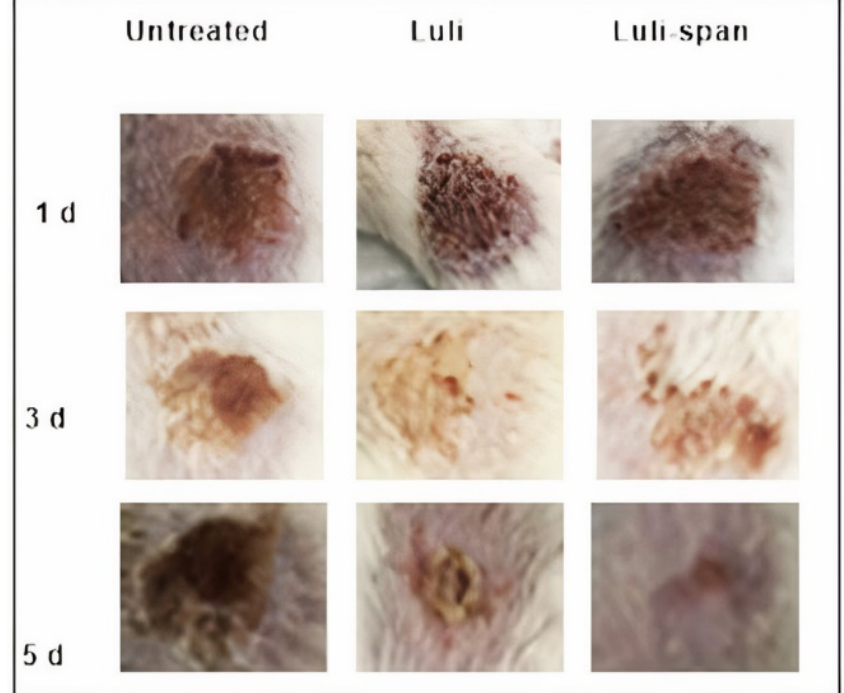
Figure 5. Macroscopic evaluation of infection was measured by a score of erythema in mice of all three groups at 1, 3 and 5 days. On the 1st day after induction of C. albicans cutaneous candidiasis, obvious infection developed in all groups. On 3rd day small recovery was observed in luliconazole (Luli group) and luliconazole spanlastics (Luli-span group). On 5th day significant recovery was observed in Luli-span group. Table 3. Colony-formingunitsof C.albicans ontheskinofmiceaftertreatmentwithdifferentformulations. Sample